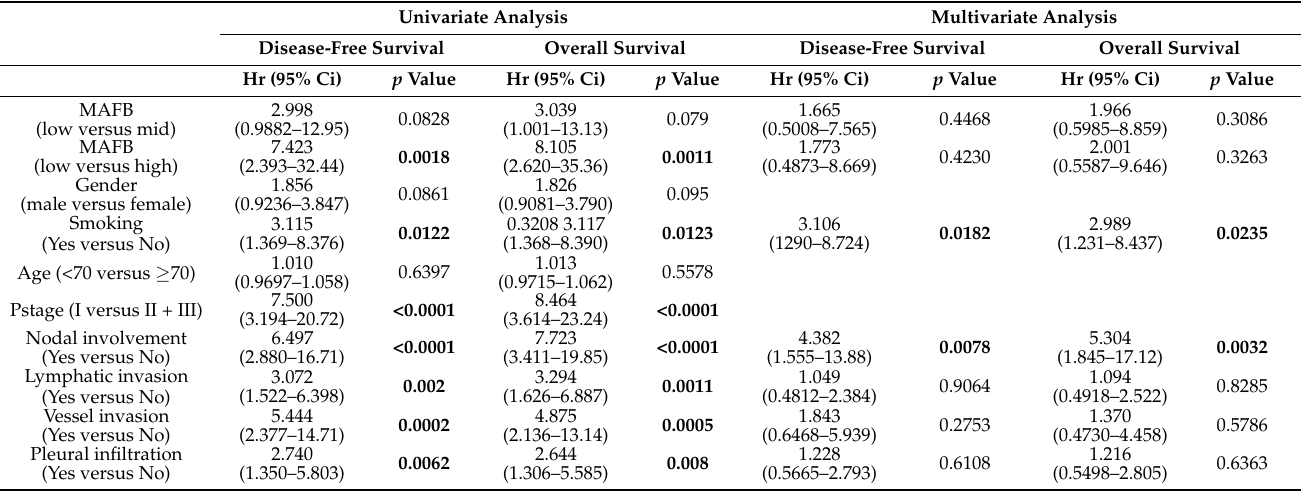
Table 2. Univariate analysis of disease-free survival and overall survival in non-metastatic lung adenocarcinoma stages. Univariate Analysis Multivariate Analysis Disease-Free Survival Overall Survival Disease-Free Survival Overall